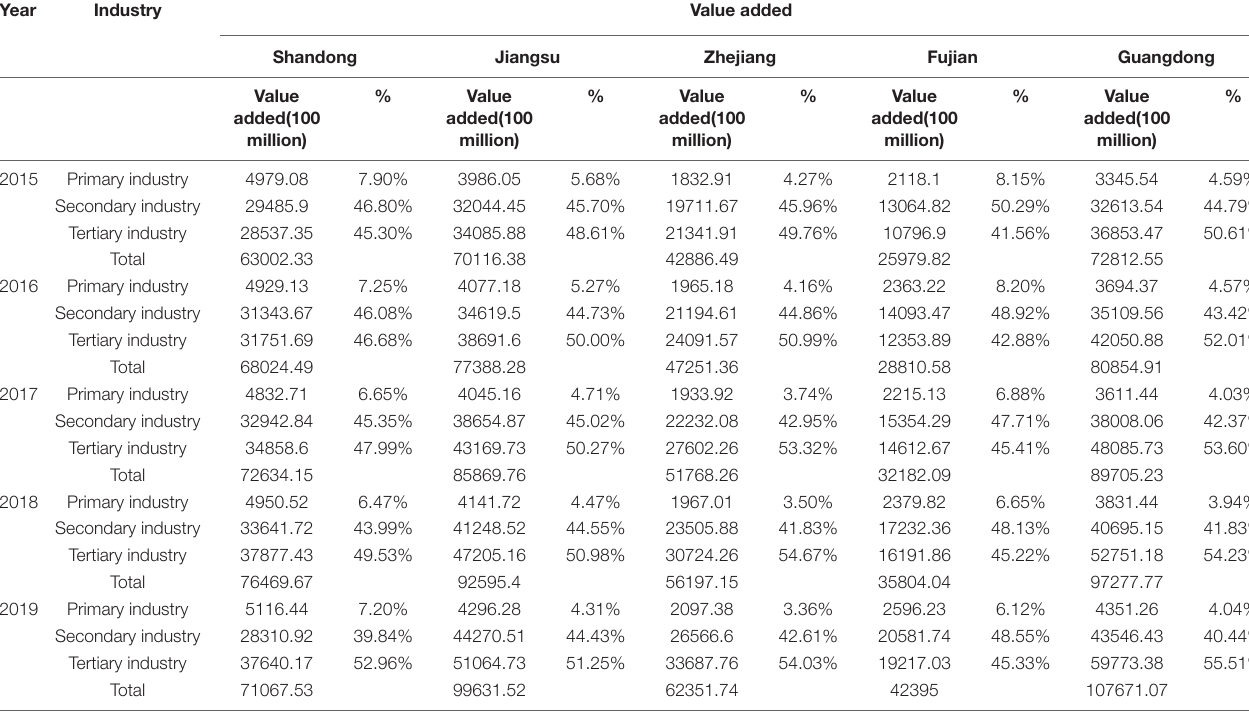
TABLE 3 | Added value by industry in the five provinces in 2015–2019.